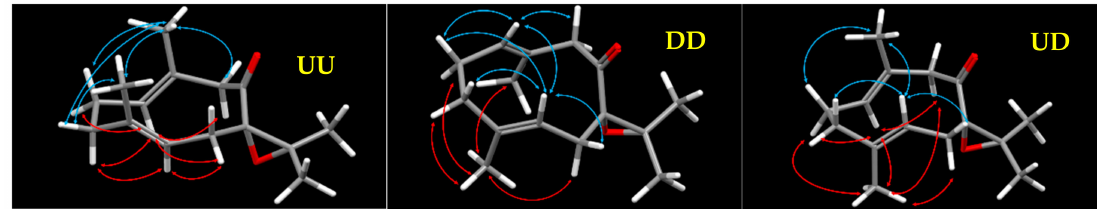
Figure 7. Observed NOEs (indicated by blue and red arrows) for the three conformers of 13 (UU, DD and UD) existing in